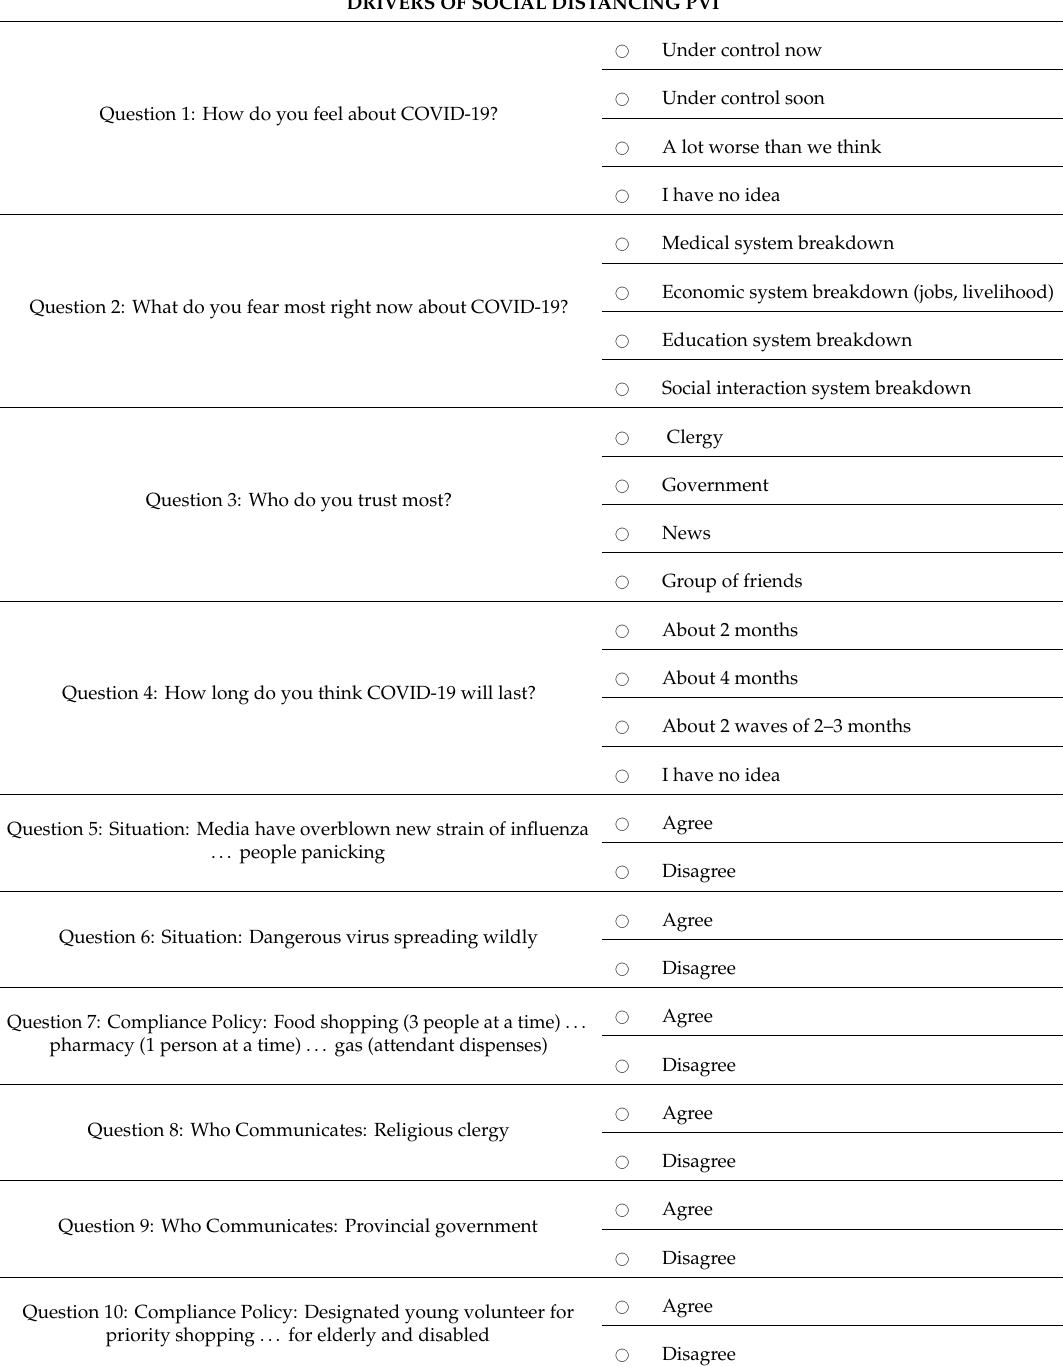
Table 5. Personal Viewpoint